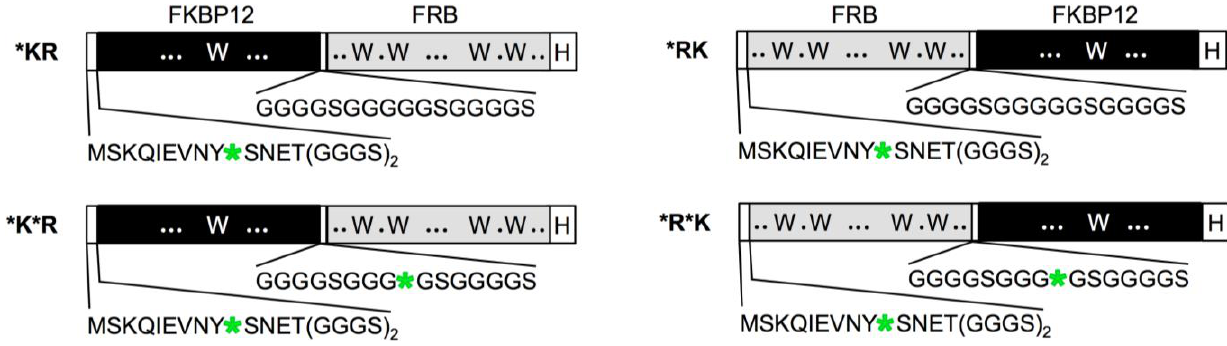
Figure 2. Schematic representation of Q’-body genes. Asterisk denotes an amber